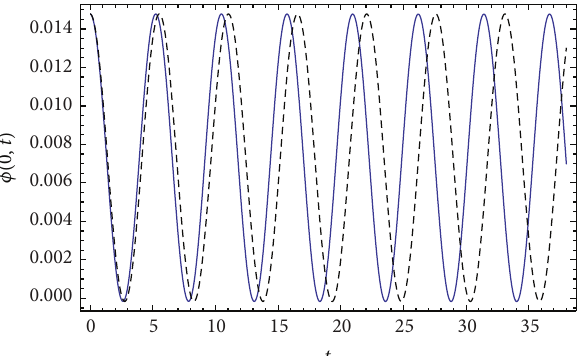
Figure 5: Analytical and numerical results. The figure is a compari- son of the field at 𝑥 = 0 . Dashed line is analytical and the solid curve is